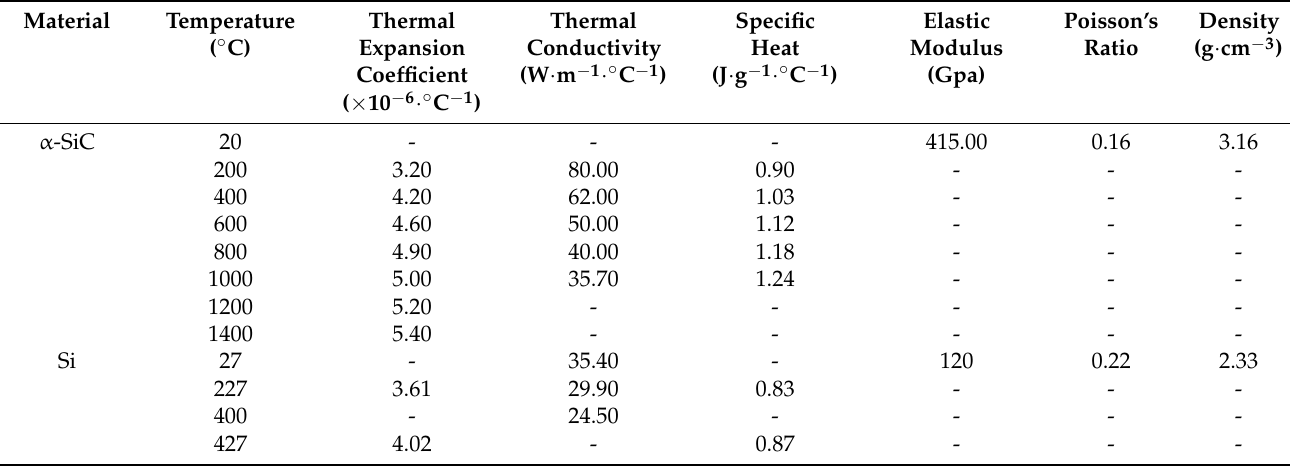
Table A1. Thermophysical parameters of substrate and